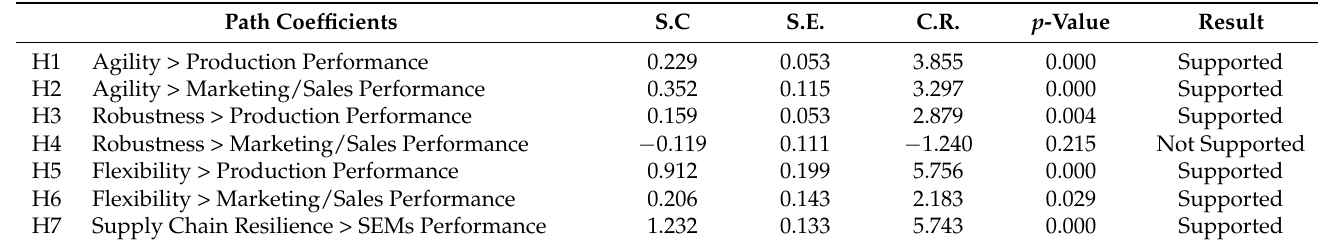
Table 9. SEM Path